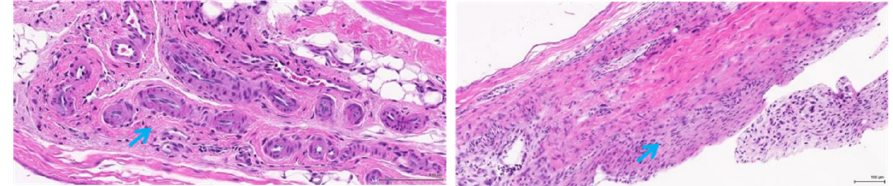
Figure 8. There is mild inflammation and fibrosis present around the nerve fibres at the grip sites